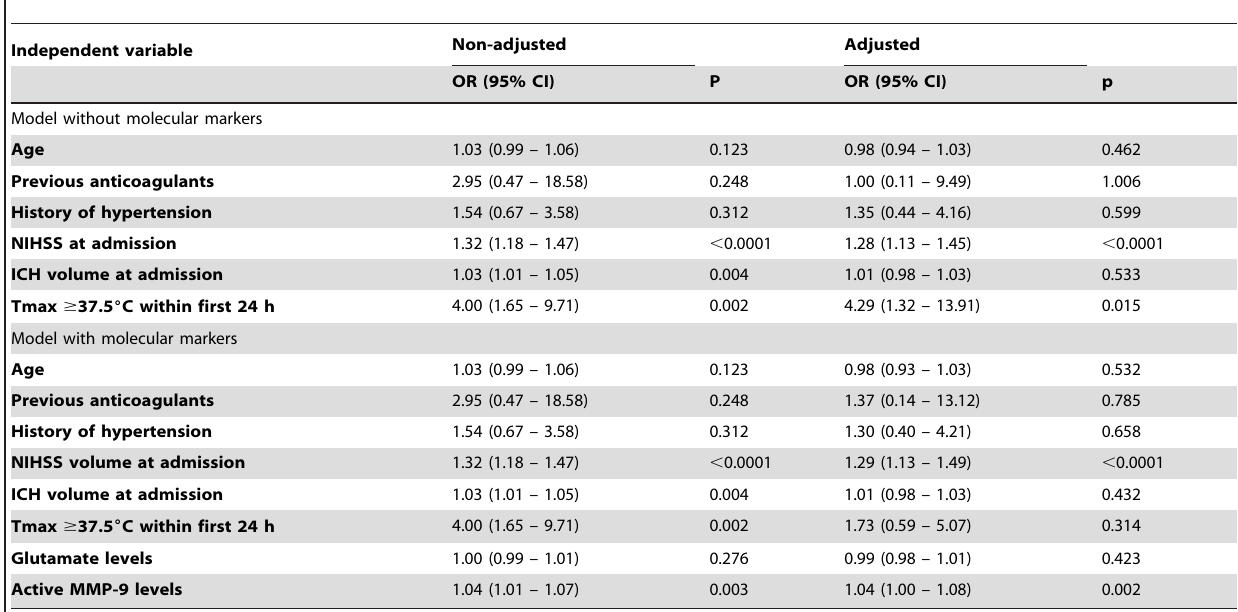
Table 3. Adjusted OR of the Tmax $ 37.5 u C within the first 24 hours and molecular markers levels for poor functional outcome at 3 months in intracerebral